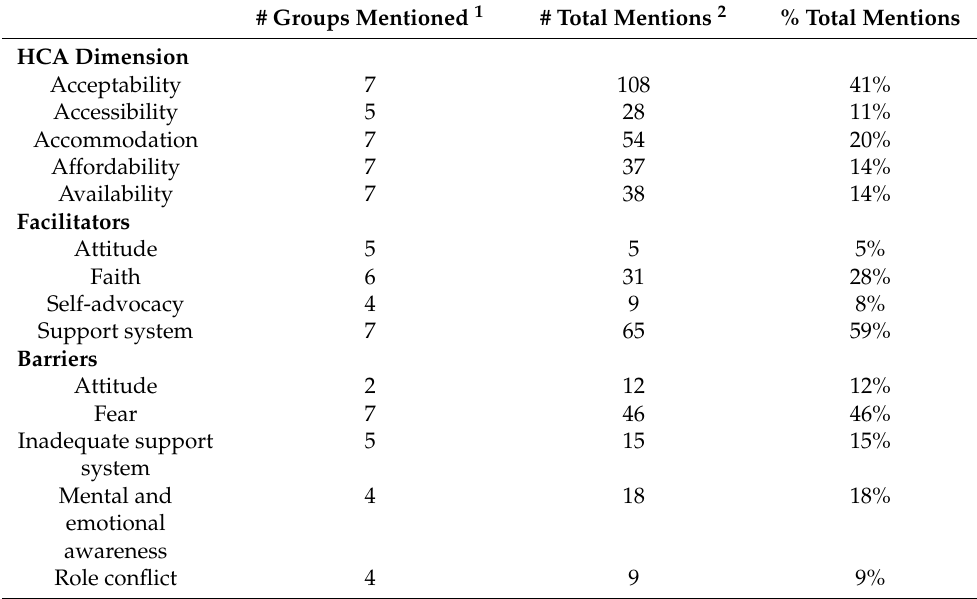
Table 2. Codes for Healthcare Access Framework, Facilitators, and Barriers to Recovery. # Groups Mentioned 1 # Total Mentions 2 % Total